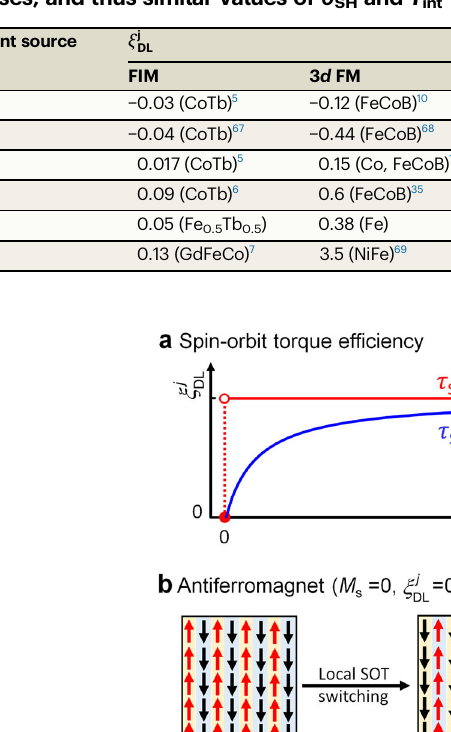
Table 1 | Comparison of ξ j with spin current sources that have similar resistivities, thicknesses, and thus similar values of θ